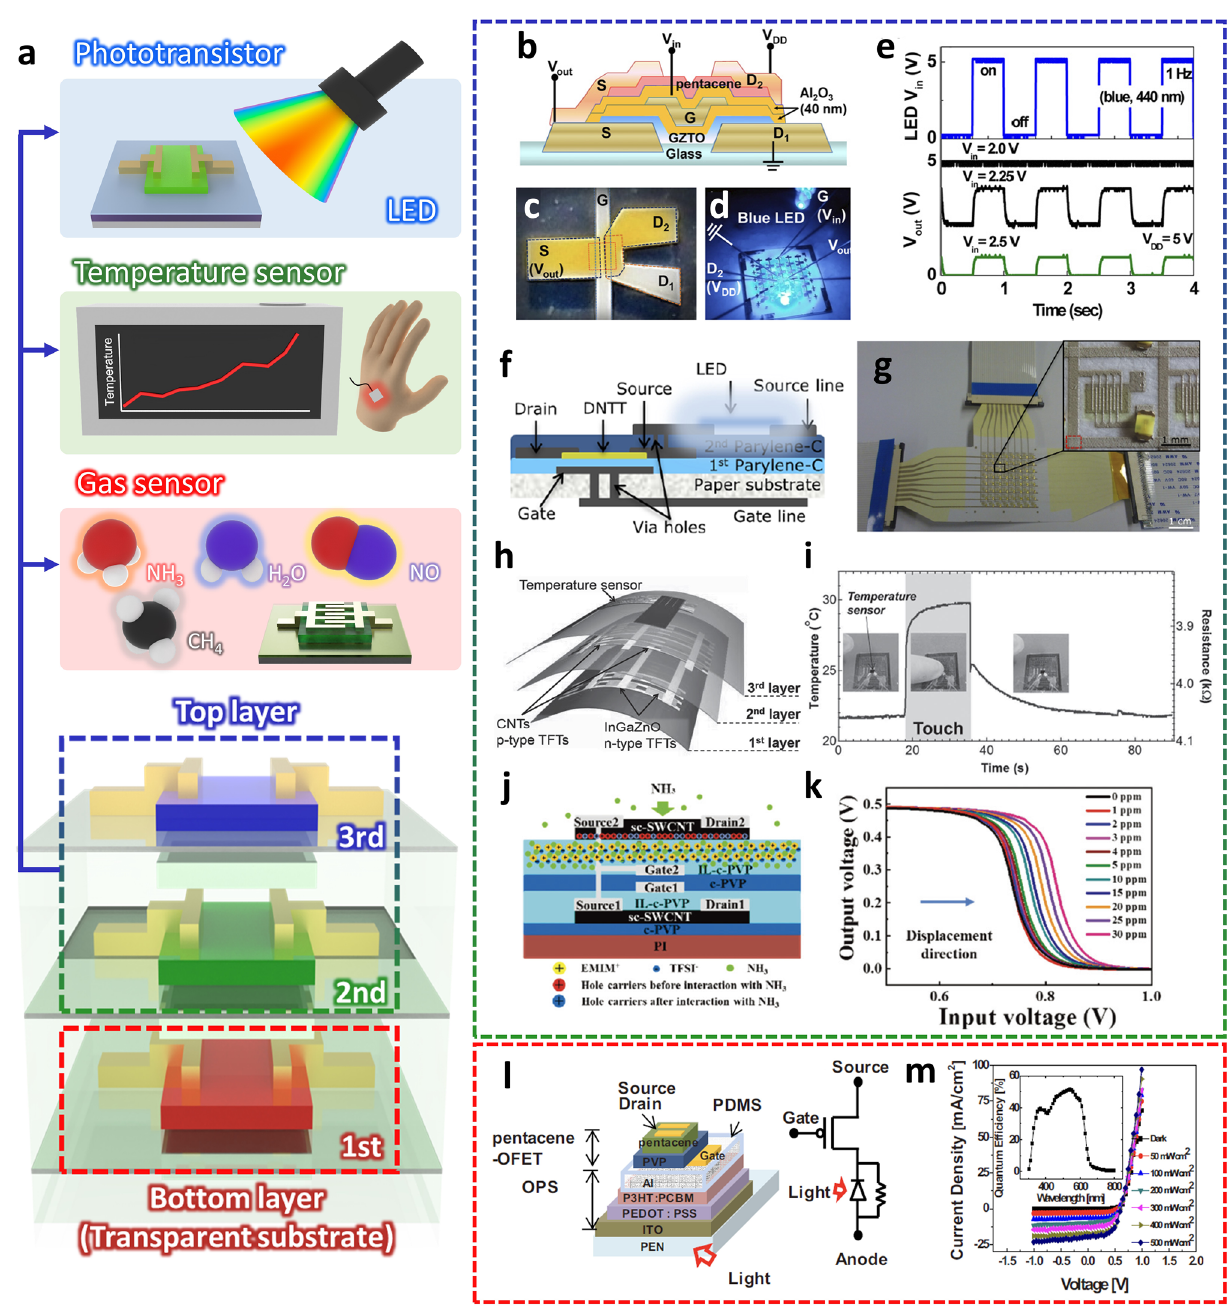
Fig. 10 a Overview of top layers suitable for placing sensor elements in vertically integrated structures . b, c Illustration and optical microscopy image of a vertically stacked inverter with a gate-sharing structure composed of pentacene and GZTO. d, e Response characteristics of the verti- cally stacked inverter according to a blue LED pulse [27]. Copyright © 2011, Elsevier. f Schematic diagram of the structure that connects the LED and the driving TFT, DNTT OTFT, through a laser drill. g Image showing the fabricated paper-based AM LED array [22]. Copyright © 2014, Springer Nature. h Schematic diagram of a vertically stacked device of CNTFET and IGZO based CMOS inverter and temperature sensor on a flexible substrate. i Real-time temperature measurement according to human hand contact [102]. Copyright © 2015, John Wiley and Sons. j Illustration of an ammonia gas sensor device based on a vertically stacked SWCNT inverter. k Shift of output voltage curve of vertically stacked SWCNT inverter with ammonia gas concentration [19]. Copyright © 2022, RSC Publishing. l Vertically integrated structures of OPS and OTFT and their equivalent circuits. m Current density–voltage characteristic of OPS device according to light intensity and curve of measured EQE [111]. Copyright © 2010, AIP